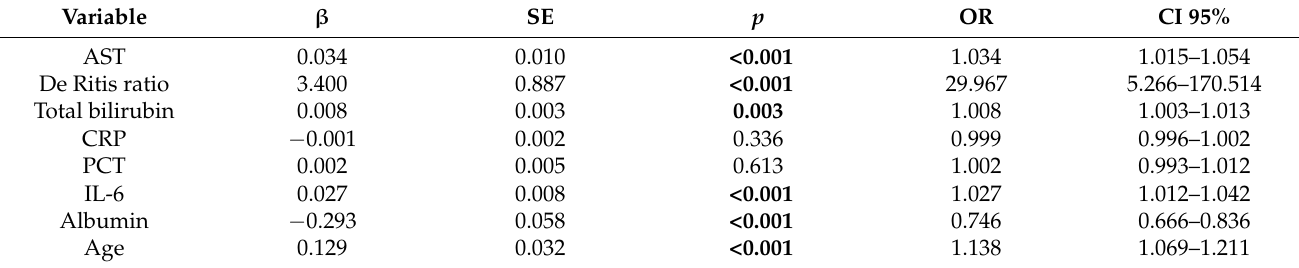
Table 3. Logistic regression for in-hospital mortality comparing seven laboratory parameters and